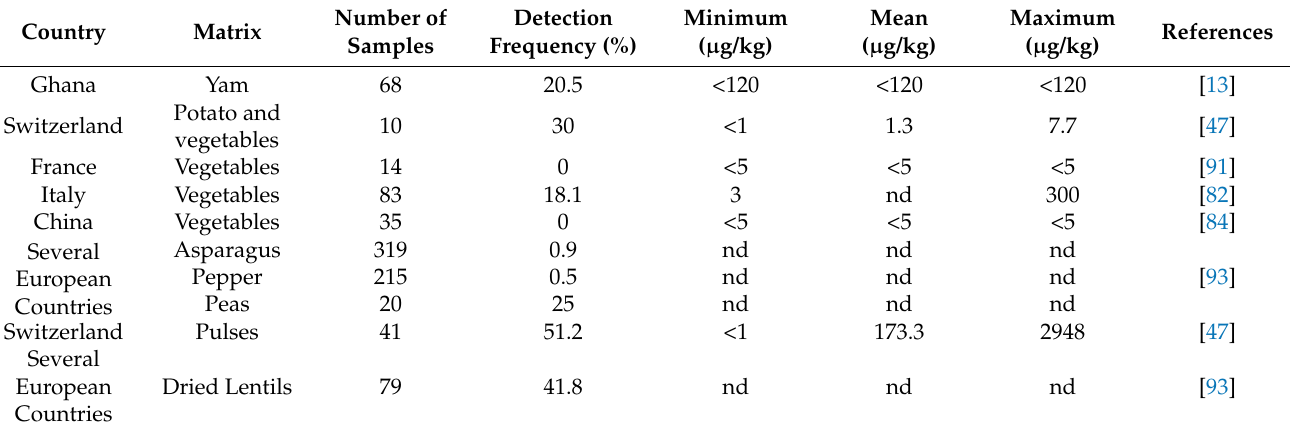
Table 7. Occurrence of glyphosate in vegetables and